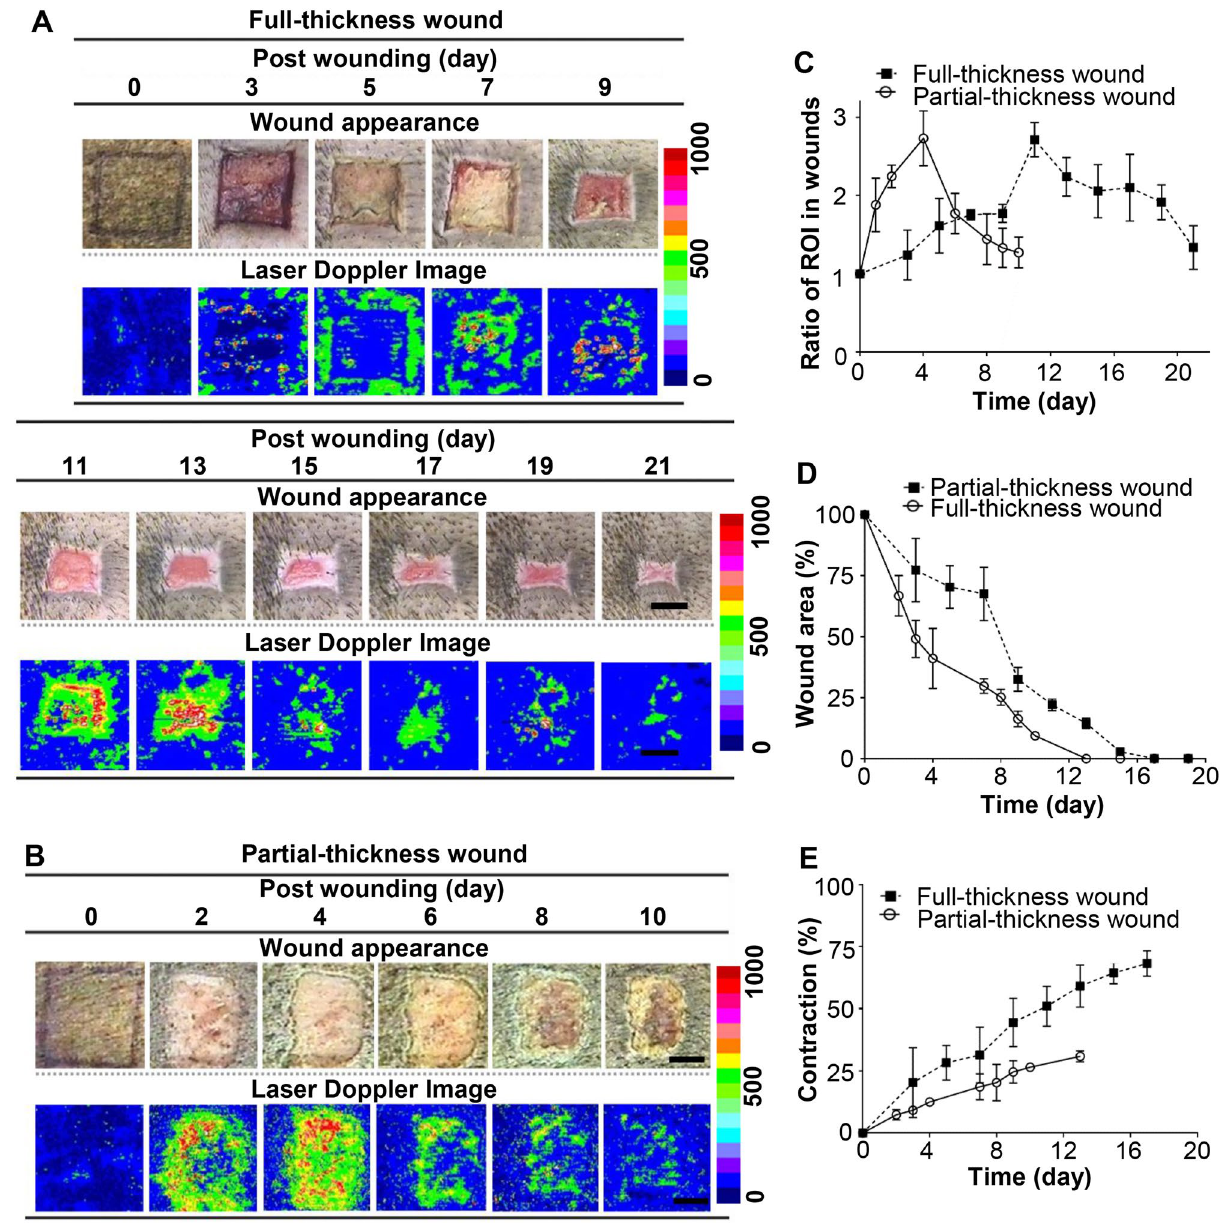
Figure 6. Comparison of partial-thickness (0.23 cm in depth) and full-thickness (0.6 cm in depth) wounds sized 2.5 cm × 2.5 cm on the dorsal skin of Lanyu pigs. Wound appearances and laser Doppler images of ( A ) full- and ( B ) partial-thickness wounds at the indicated time points postoperatively (bar = 1 cm). ( C ) The ratios of ROI of laser Doppler flowmetry were quantified for partial- and full-thickness wounds at indicated time points. ( D ) The percentage of wound area compared with each original wound size was calculated individually for partial- and full-thickness wounds at indicated time points. ( E ) The percentages of wound contraction were calculated for partial- and full-thickness wounds at indicated time